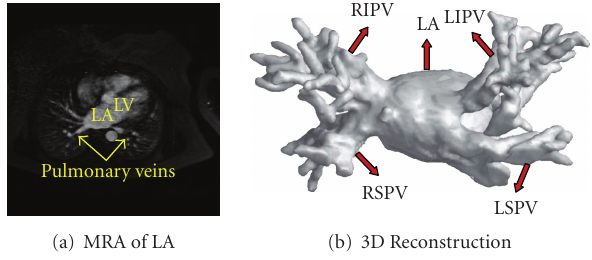
Figure 5: The 3D patient data: (a) MRA of LV and (b) 3D recon- struction result of the given